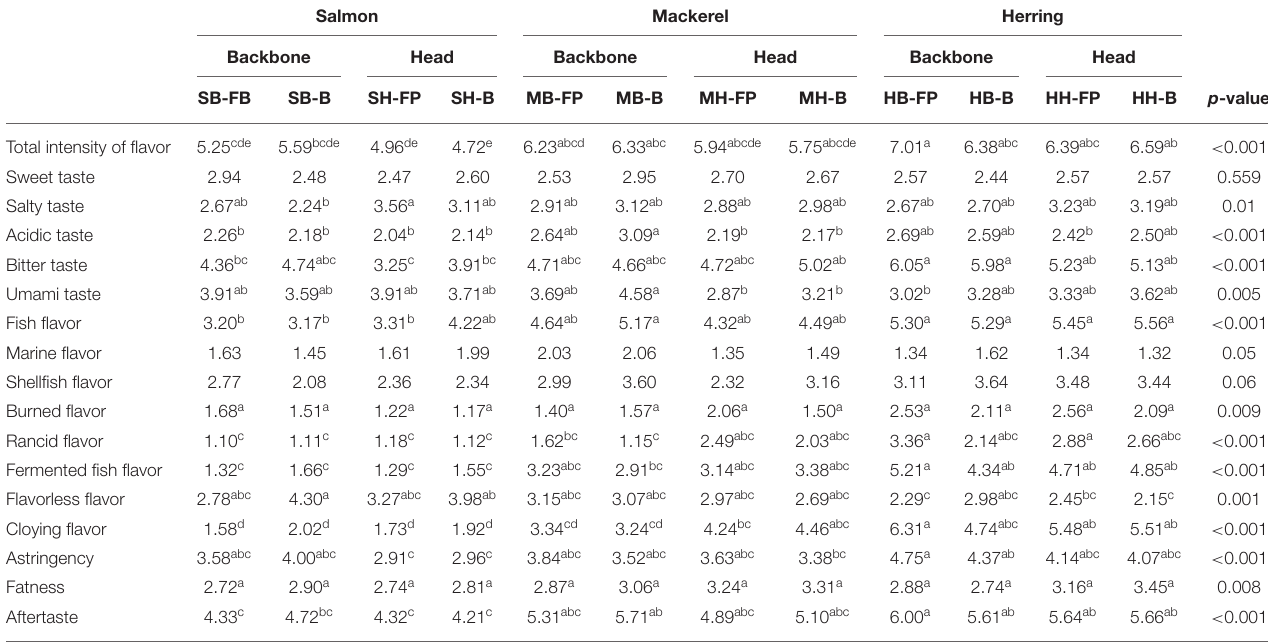
TABLE 6 | Mean sensory intensity values of protein hydrolysates based on salmon (S), mackerel (M), and herring backbones (B) and heads (H) using Food Pro PNL (-FB) and Bromelain (-B). Salmon Mackerel Herring Backbone Head Backbone Head Backbone Head SB-FB SB-B